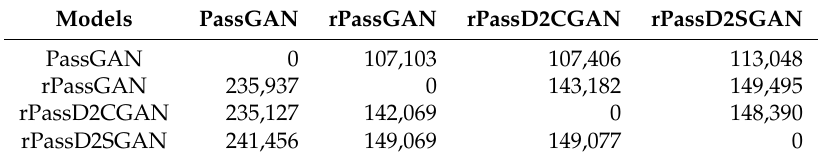
Table 4. Difference between each deep learning model’s cracking result